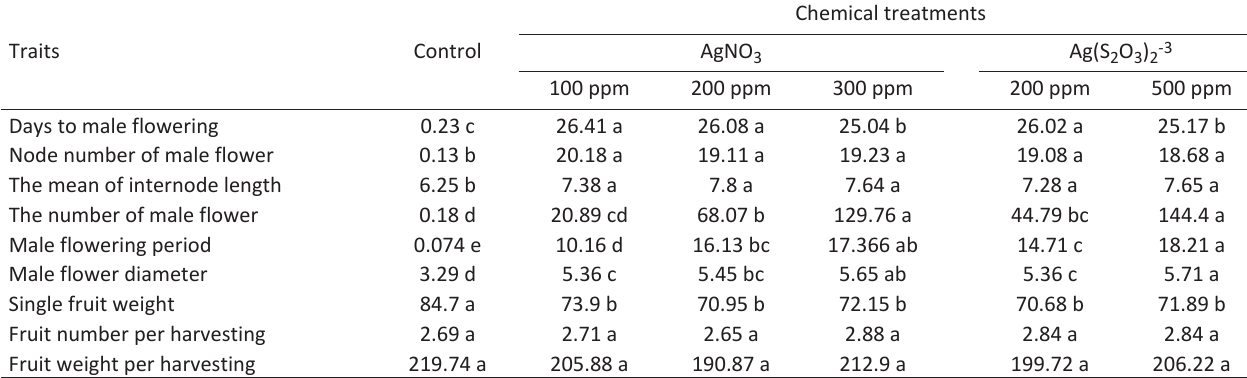
Means followed by the same letter in each row were not significantly different at 0.05 level using LSD